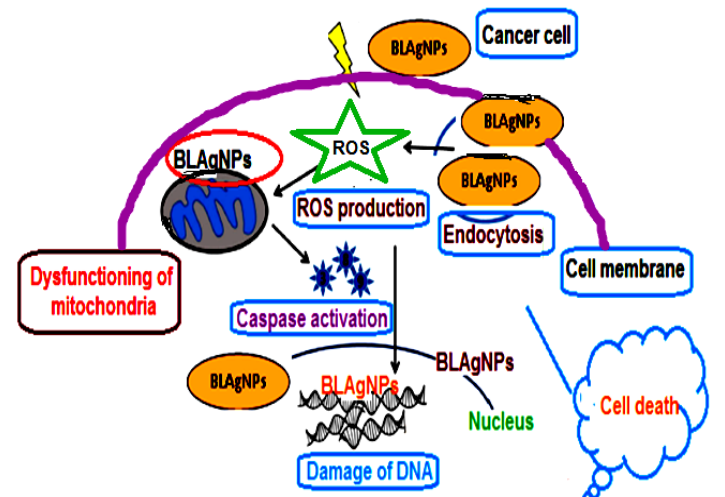
Fig. 13. Mechanism of anticancer activity of BLAgNPs on cancer cells Fig. 13 Mechanism of anticancer activity of BLAgNPs on cancer cells